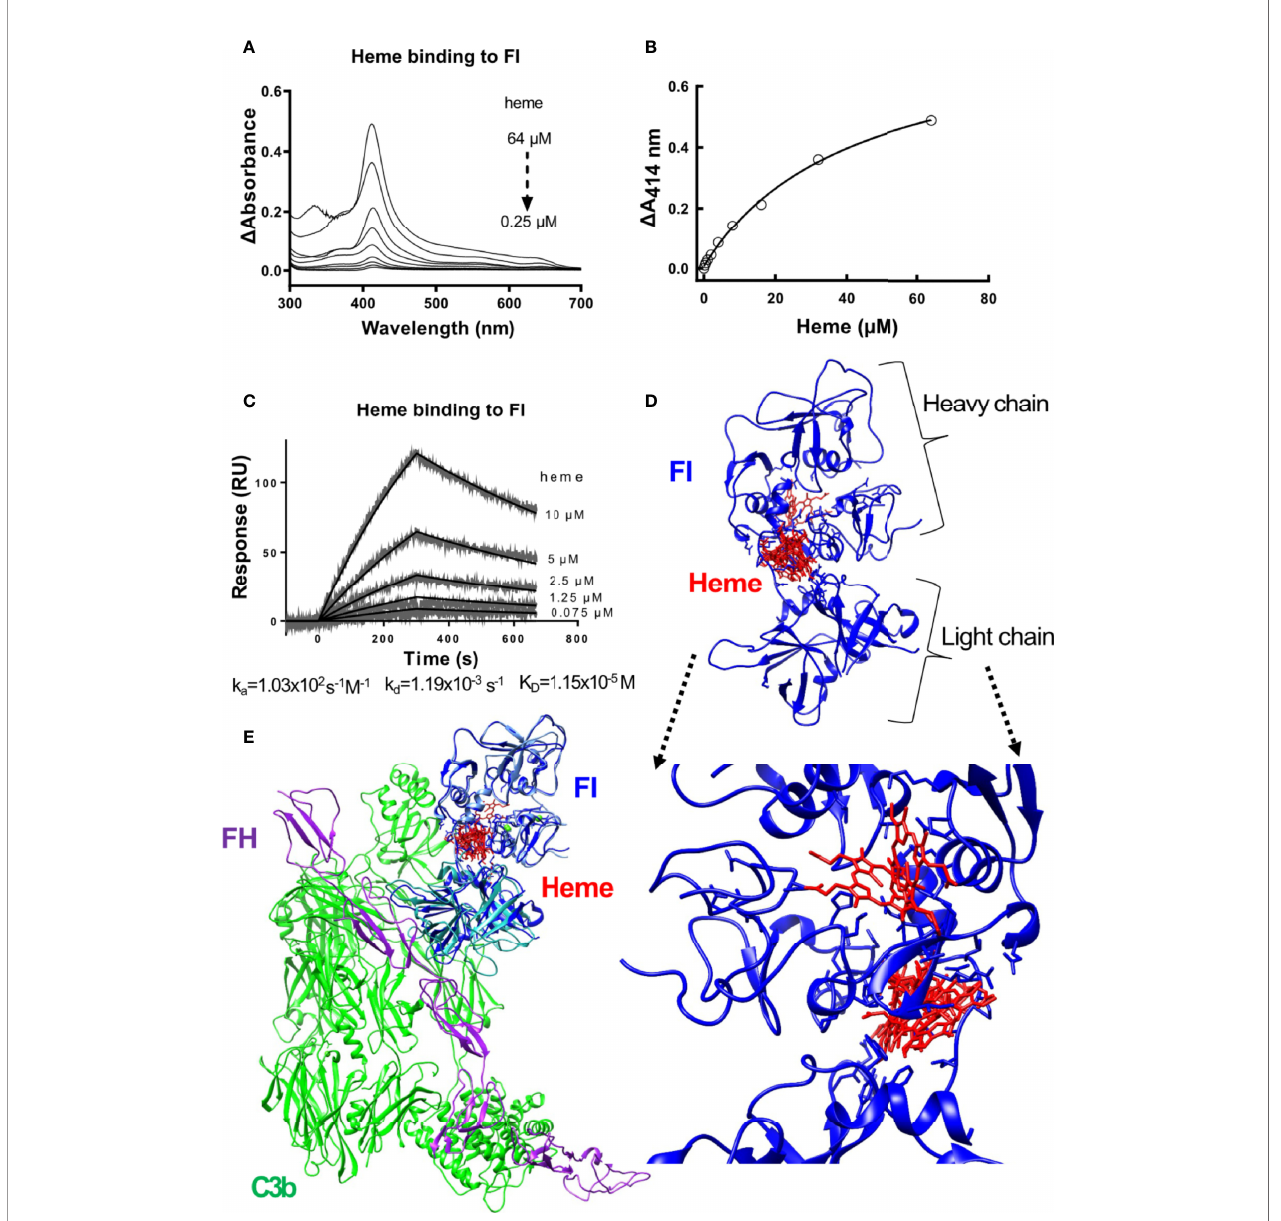
FIGURE 1 | Heme binding to factor I (A, B) Absorbance spectroscopy of heme (0.25-64 m M) binding to factor I (FI) from Comptech, shown as an absorbance spectrum (A) and at wavelength 414 nm (B) . (C) SPR analysis of the binding of different concentrations of heme to factor I (Comptech) immobilized on a Biacore sensor chip. (D) Molecular docking of heme (red) to factor I (blue). The top ten complexes are visualized. (E) Overlap of the factor I-heme complexes with the structure of the complex C3b/fH1-4:19-20/FI